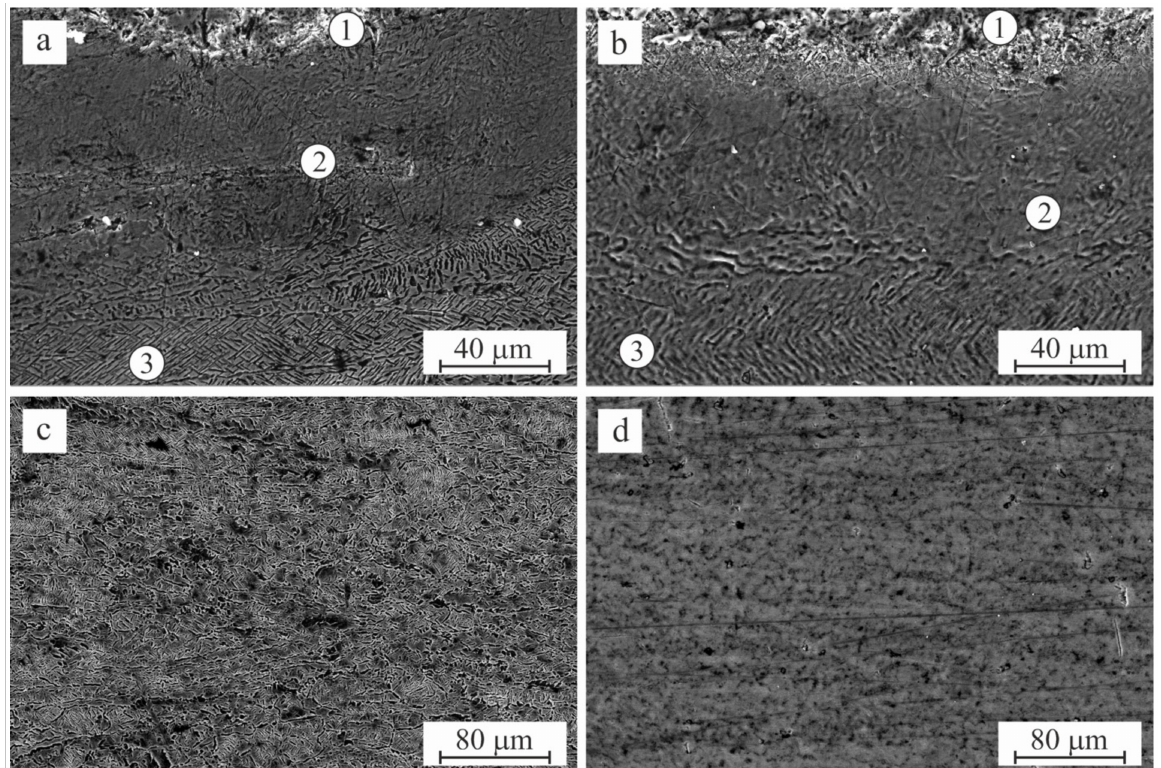
Figure 3. Microstructure of the surface layer of the α + β titanium alloy after EMT ( a ) j = 300 A/mm 2 ; ( b ) j = 600 A/mm 2 ; ( c ) j = 300 A/mm 2 + aging; ( d ) j = 600 A/mm 2 + aging; 1—sample surface (oxide film); 2—near-surface layer after EMT (series 2); 3—initial structure of the titanium alloy (as